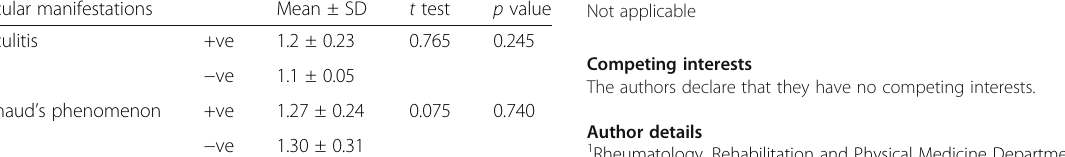
Table 5 Endocan levels in patients regarding vascular manifestations of RA patients Vascular manifestations